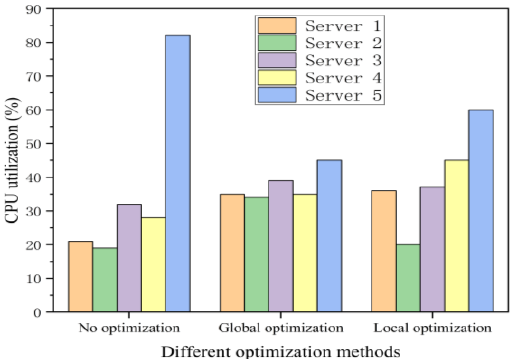
Figure 8. CPU utilization comparisons among the local optimization, no optimization, and global optimization methods.